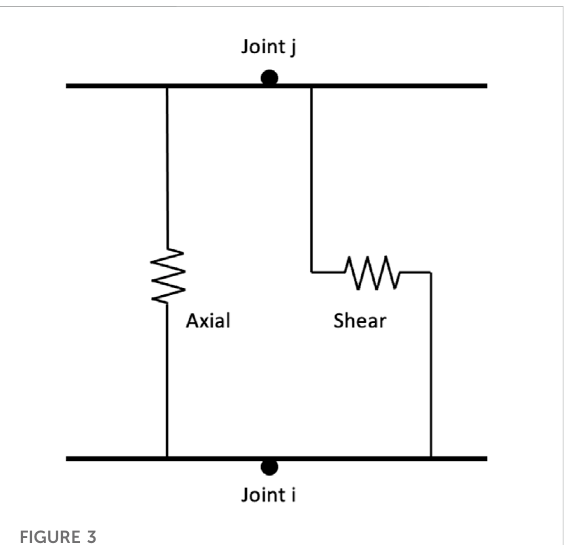
FIGURE 3 Sketchofaxialandshearspringswithinanon-linearlink[after CSi America